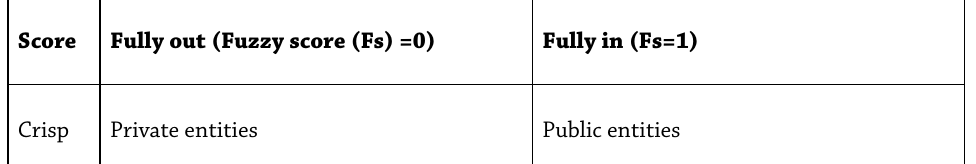
Crisp Private entities Public